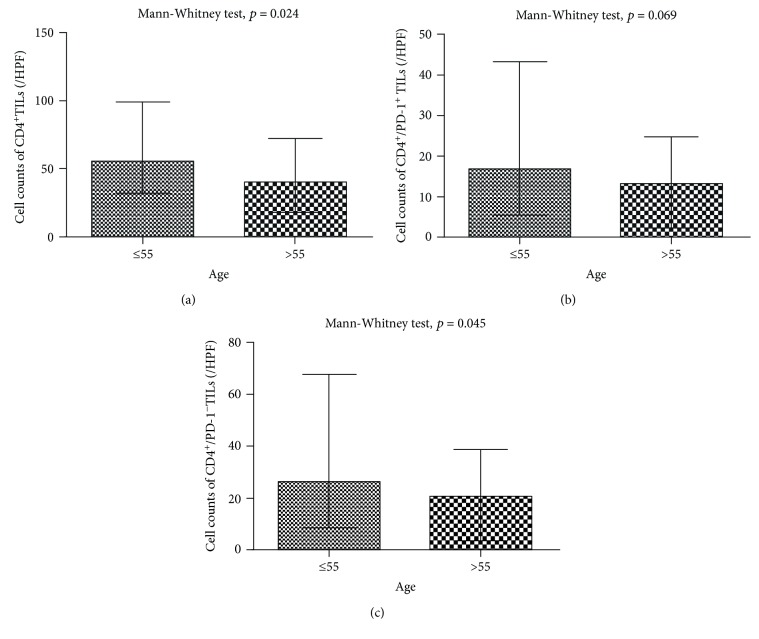
Relationship between age and CD4/PD-1 phenotypes of TILs. (a) Relationship between age and CD4+ TILs. (b) Relationship between age and CD4+/PD-1+ TILs. (c) Relationship between age and CD4+/PD-1− TILs.